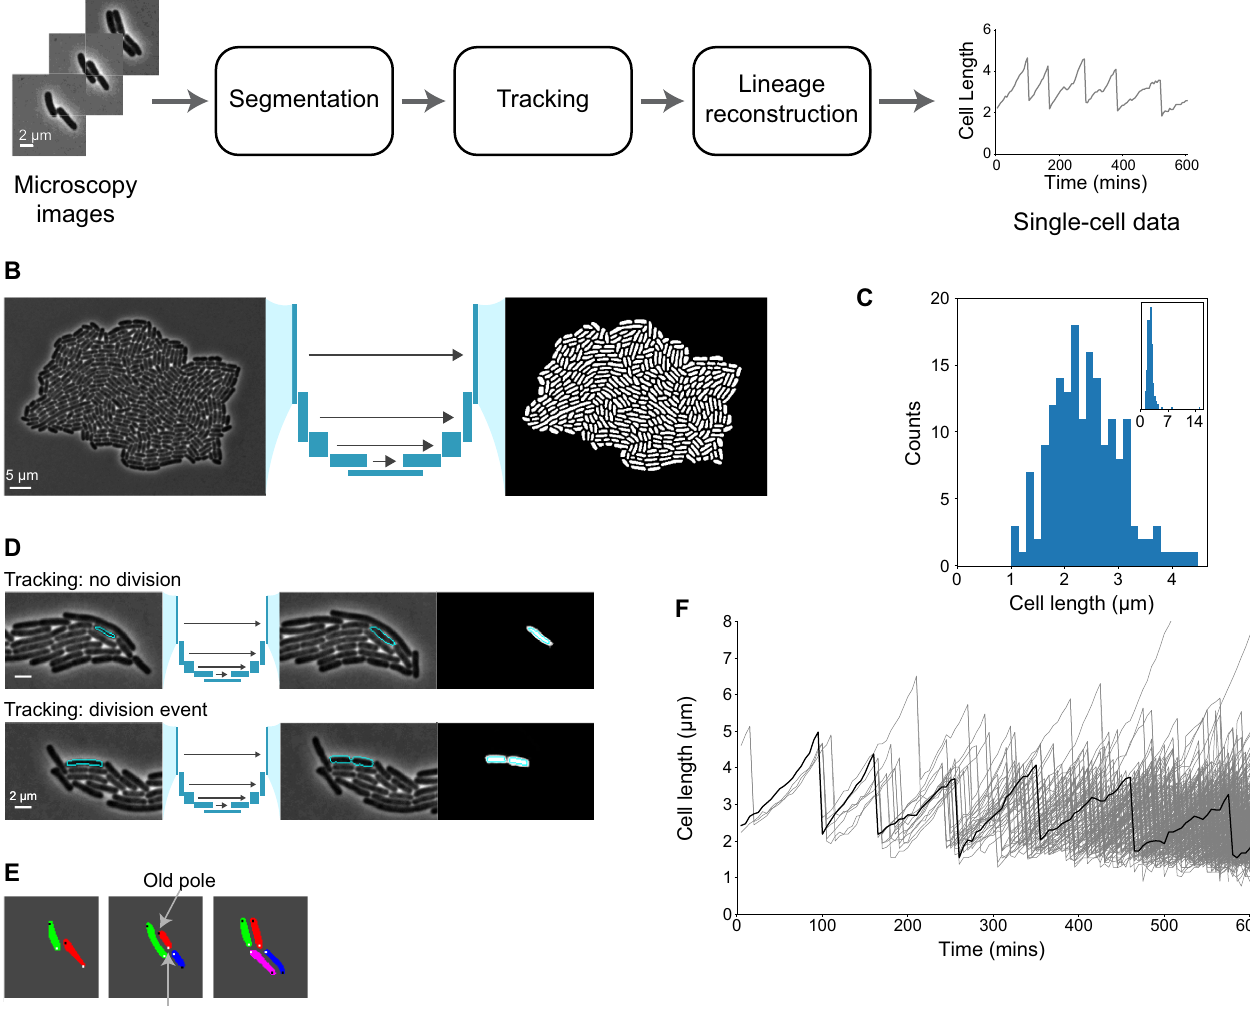
Fig 1. Segmentation and tracking of cells within a microcolony. (A) DeLTA pipeline consists of segmentation, tracking, and lineage reconstruction. (B) Segmentation example with phase contrast image containing an E . coli microcolony, which is input into a U-Net convolutional neural network to obtain segmentation results. (C) Histogram of cell lengths. Inset shows a zoomed-out version with outliers included. (D) Cell tracking between frames. Representative examples of cell tracking with and without division are shown with a phase contrast image of the ‘previous frame’ on the left, a phase contrast image of the ‘current frame’ in the middle, and a greyscale image of the ‘prediction’ on the right. The ‘current frame’ also shows the tracking prediction overlayed. The ‘prediction’ shows the U-Net output with the ground truth overlayed (S1 Fig). (E) Lineage reconstruction keeps track of cell lineages and records pole age. (F) Plot of cell lengths over time. Black line is a representative example of one cell’s length as it grows and divides; all cells in the microcolony are shown in grey.